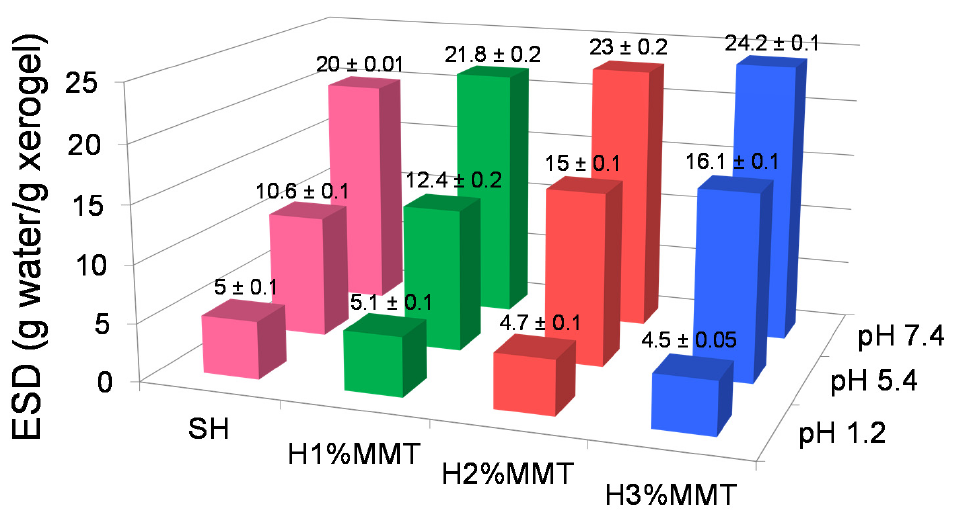
Figure 9. The influence of the reinforcing agent on the swelling degree (72 h) at different pH values. Results express average values ± standard errors. SH: 10%MAA, 2 mol%BIS based on MAA, 0%MMT.